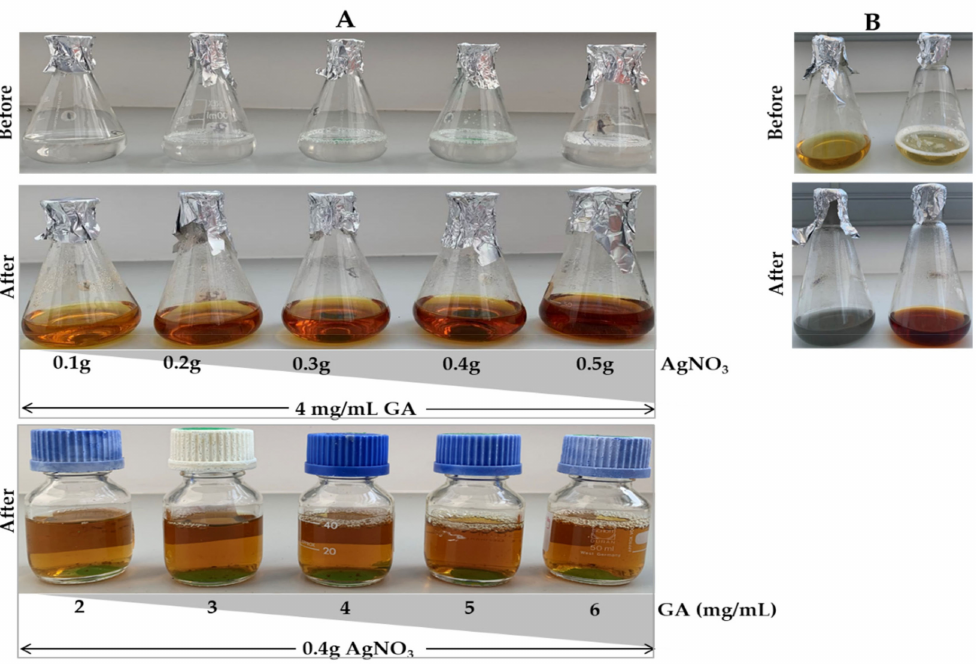
Figure 1. Synthesis of GA-AgNPs using green ( A ), chemical and combined ( B )